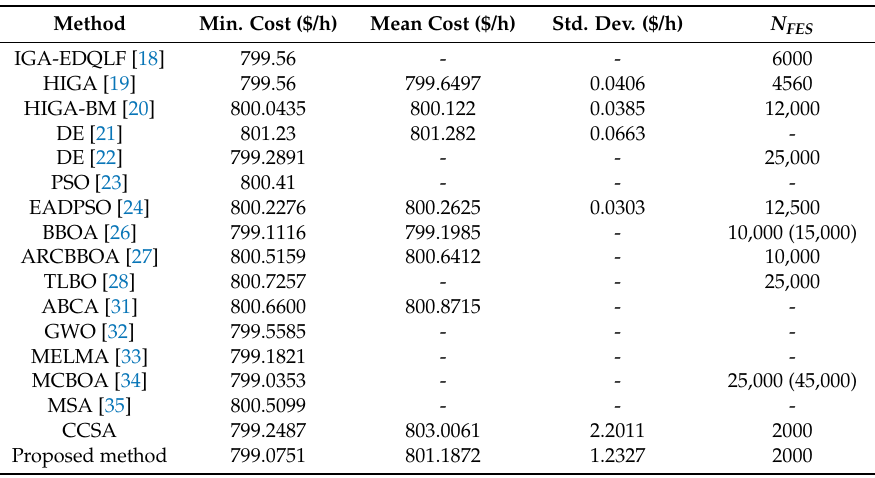
Figure 9. Fitness function of 100 runs obtained by the CCSA and proposed method in sub-case 3.1. Table 6. The result comparison for subcase 3.1.